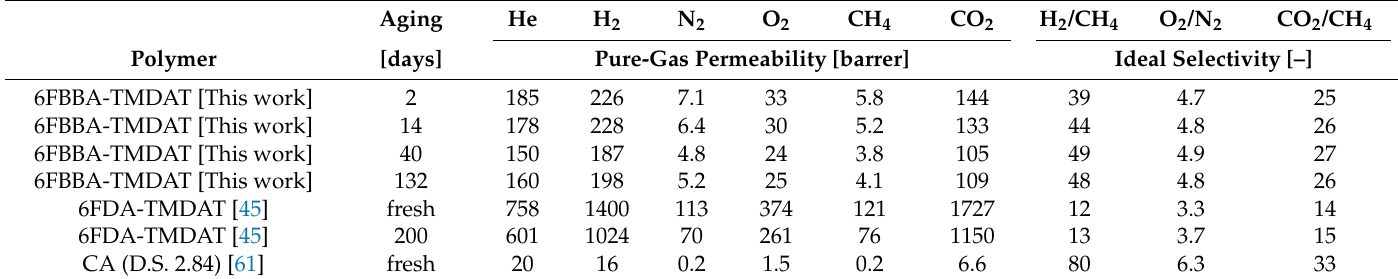
Table 2. Aging time [days], permeability [barrer], and permselectivity of 6FBBA-TMDAT polyamide and 6FDA-TMDAT polyimide [45] films for pure gases at 35 ◦ C and 2 atm; the conventional commercial cellulose acetate (CA) [61] is also listed for comparison.